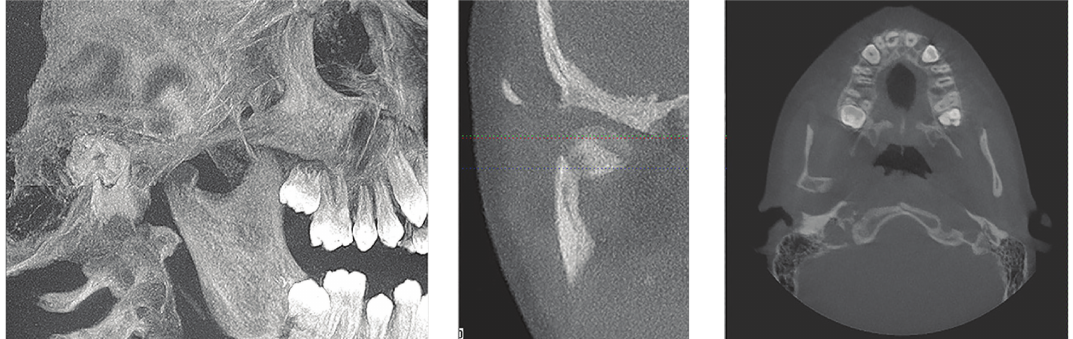
Figure 3: 3D, axial, and coronal views of the right condyle, showing the medially displaced subcondylar fracture.